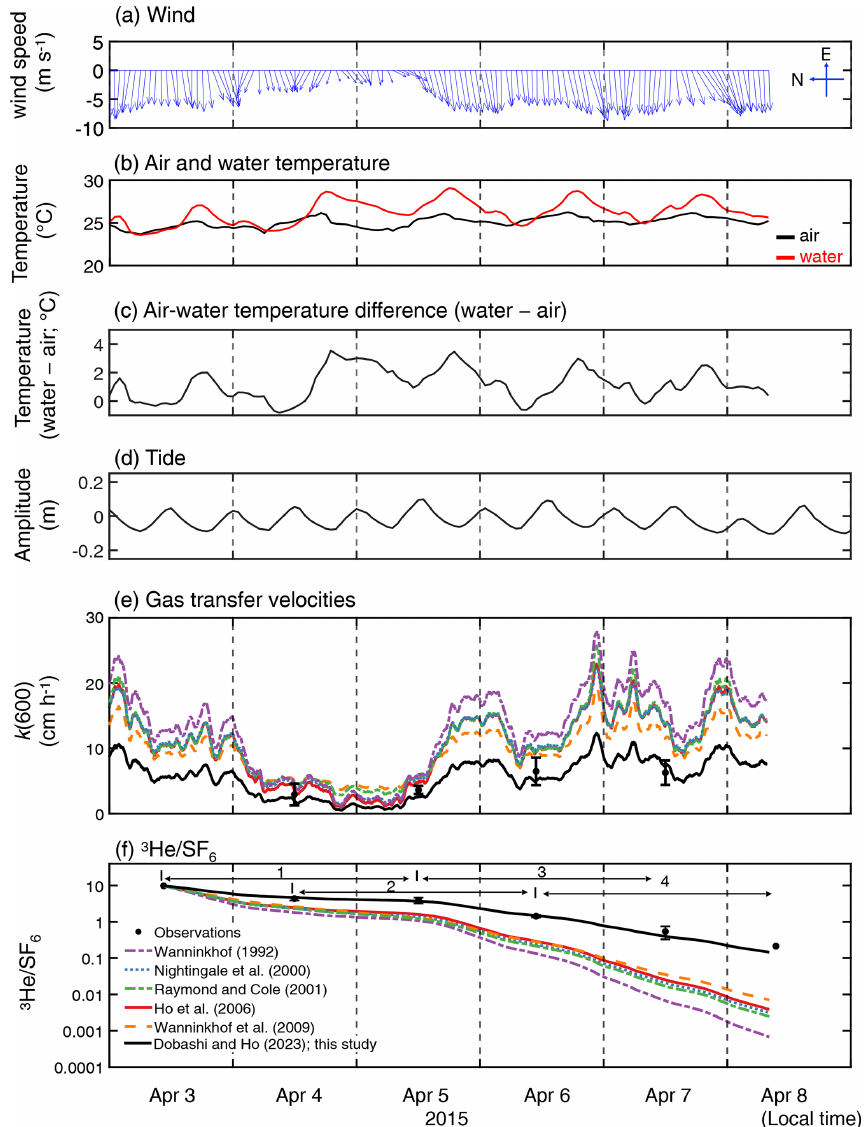
Figure 2. Time series of (a) hourly averaged wind vector at 10m height (ms − 1 ), (b) water temperature and air temperature ( ◦ C), (c) tem- perature difference (water temperature minus air temperature; ◦ C), (d) tidal amplitude (m), (e) measured and estimated k (600) which is the gas transfer velocities normalized for 20 ◦ C freshwater CO 2 and (f) measured and modeled change in 3 He / SF 6 . Note that the wind direction is towards the north when the vector is towards the left. The time zone is local time. The figure legend for (e) is the same as that in (f) . The numbers in (f) indicate the periods corresponding to the x axis in Fig.